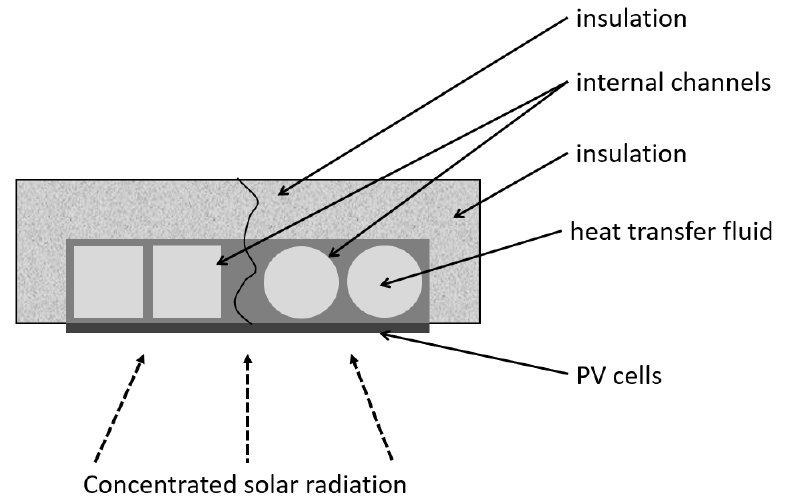
Figure 16. The cross-sectional view of typical heat receiver with internal channels.